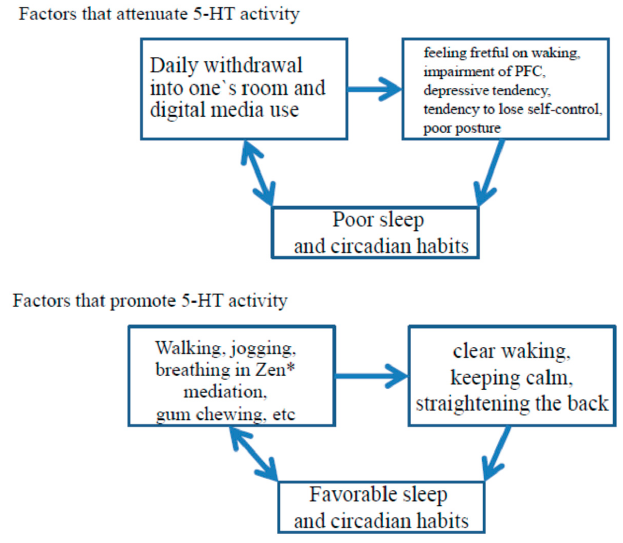
Figure 2. Adapted from Arita [41] JMAJ 2009 , 52 , 184. Copyright © 2009 with permission from Japan Medical Association (the tiltle of original figure is “means of increasing